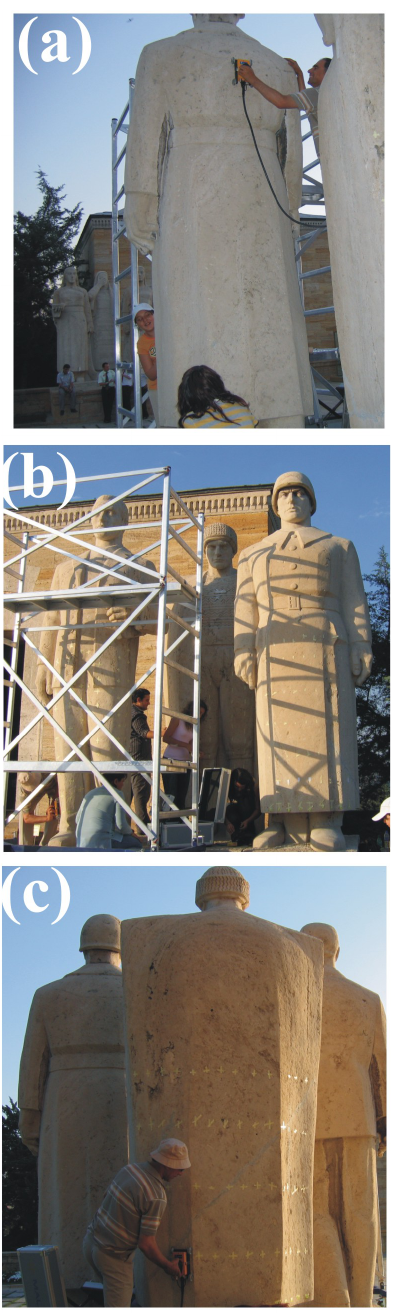
Fig. 5. (a) Data acquisitions on the back of the first man statue between the waist and the neck, (b) on the second man statue, and (c) below the waist of the back of the third man statue.